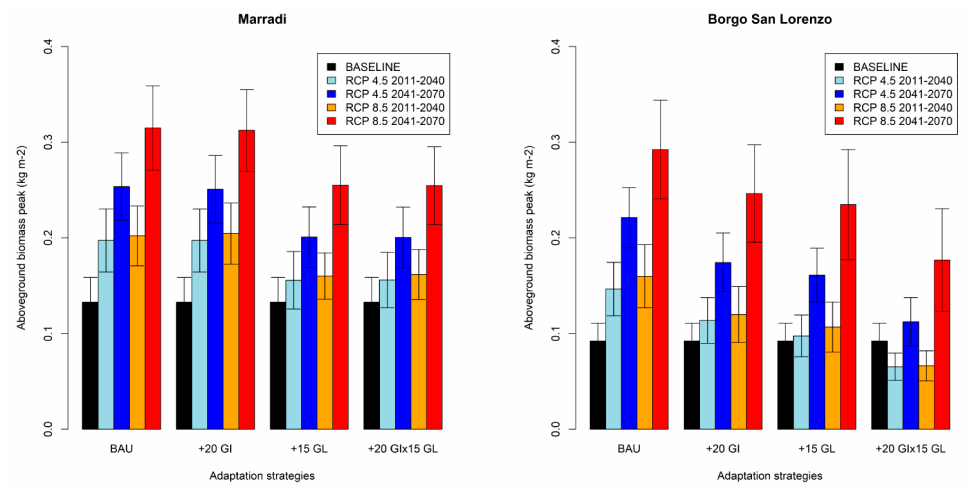
Figure 8. Changes in peak aboveground biomass (kg DM m -2 ) among business-as-usual management (BaU) under the baseline climate (black histogram) and all alternative management options under RCP4.5 (cyan and blue histograms) and RCP8.5 (orange and red histograms) in both sites as provided by PaSim. Vertical bars are standard deviations.